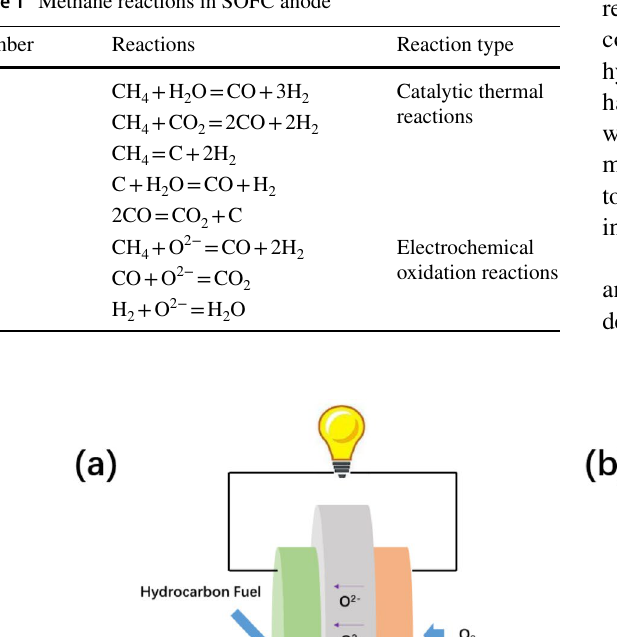
well as the consumption rate of methane. d The selectivities to the CO, CO 2 and C 2+ as a function of overpotential. P CH4 = 9 kPa, =3 kPa, T = 1000 °C, F = 100cm 3 /min. Reproduced with